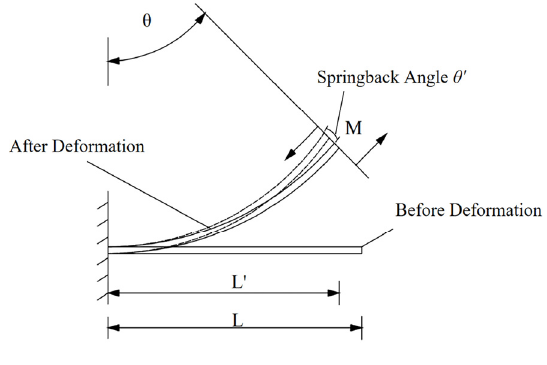
Figure 8. Bending of sheet metal.